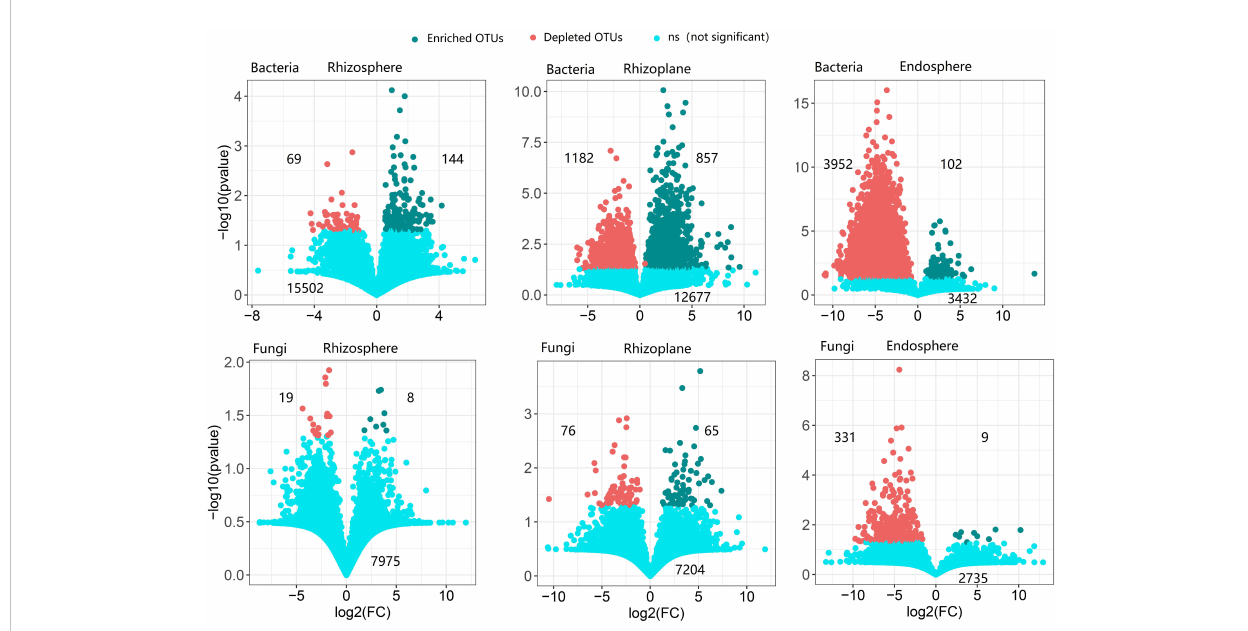
FIGURE 3 The enrichment and depletion patterns of the root-associated bacterial and fungal microbiomes in each compartment compared with soil. Each green point represents an individual enriched OTU, and a red point represents an individual depleted OTU. The x-axis represents the fold change (FC) in the abundance of a speci fi c compartment compared with soil, and the y-axis reports the negative value of the logarithm (base10) of the p - value. Numbers on the top left of the panel indicate depleted OTUs, and numbers on the top right of the panel indicate enriched OTUs, while numbers on the bottom of the panel indicate not-signi fi cant